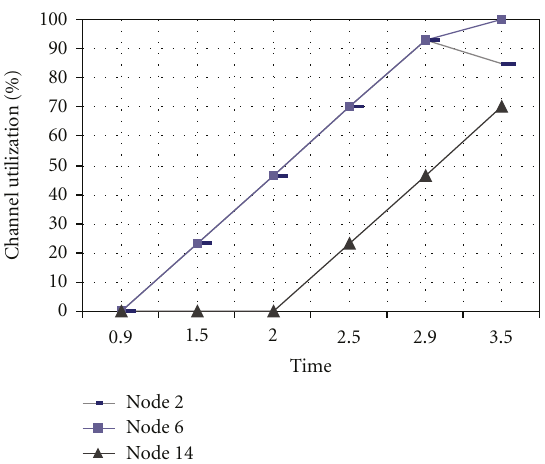
Figure 4: Channel utilization (%) with respect to three flows (1, 2, 3) versus time. RTS/CTS mechanism is